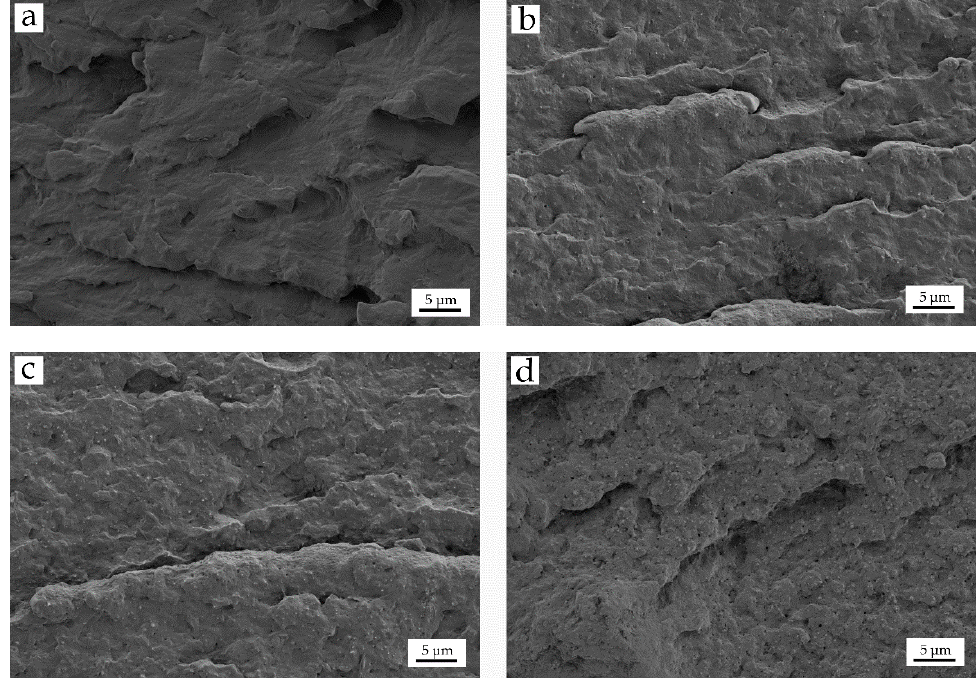
Figure 1. Field emission scanning electron microscopy (FESEM) images at 2000 × of the fracture surfaces of PA610/HNT composites: ( a ) PA610; ( b ) PA610/10HNTS; ( c ) PA610/20HNTS and ( d ) PA610/30HNTs.